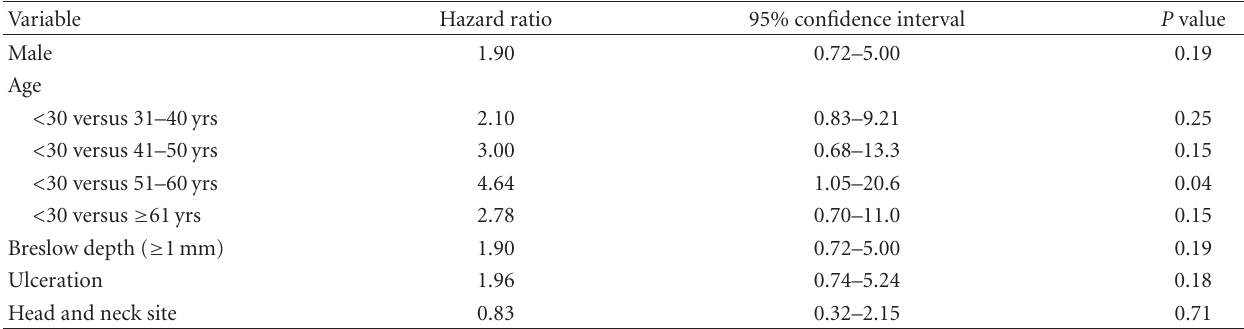
Table 4: Multivariable model of distant recurrence versus regional recurrences (only SLN negatives and distant/regional recurrences, n = 107).